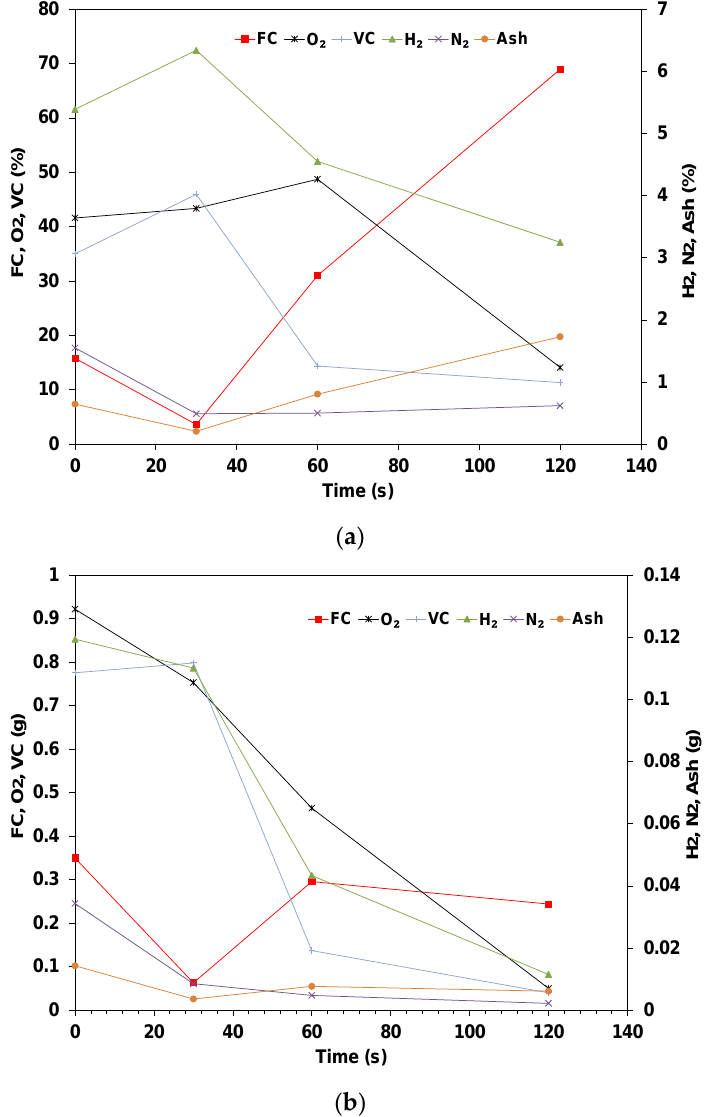
Figure 10. Elemental analysis of wood pellets at 734 °C: ( a ) in percentages and ( b ) in grams. The total Carbon will decrease with time as it is oxidized. This is observed in Figure 12, where the total mass of Carbon is made dimensionless with the initial mass of Carbon. It shows that the mass loss of Carbon at different temperatures changes with time. This